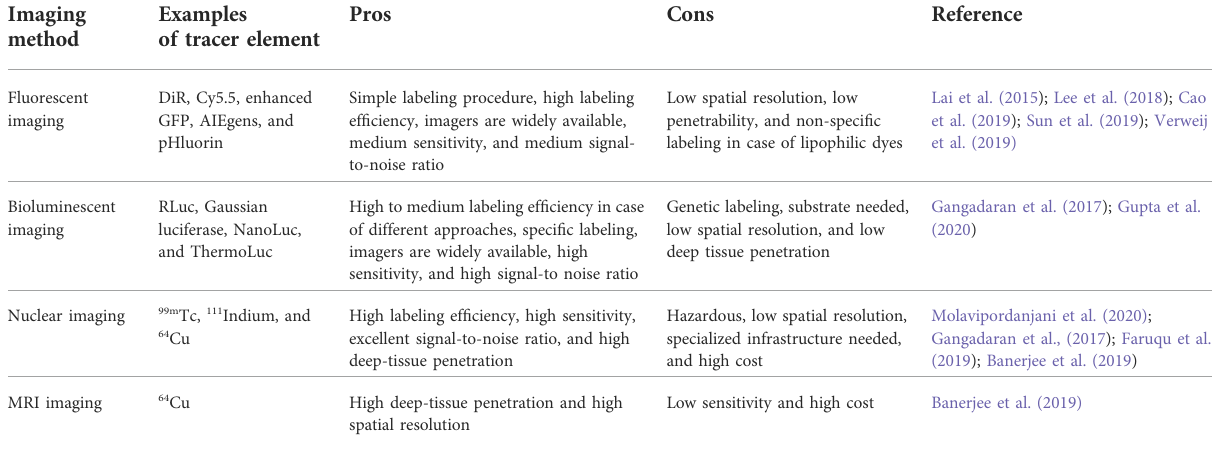
TABLE 1 Comparison of the principal imaging methods for